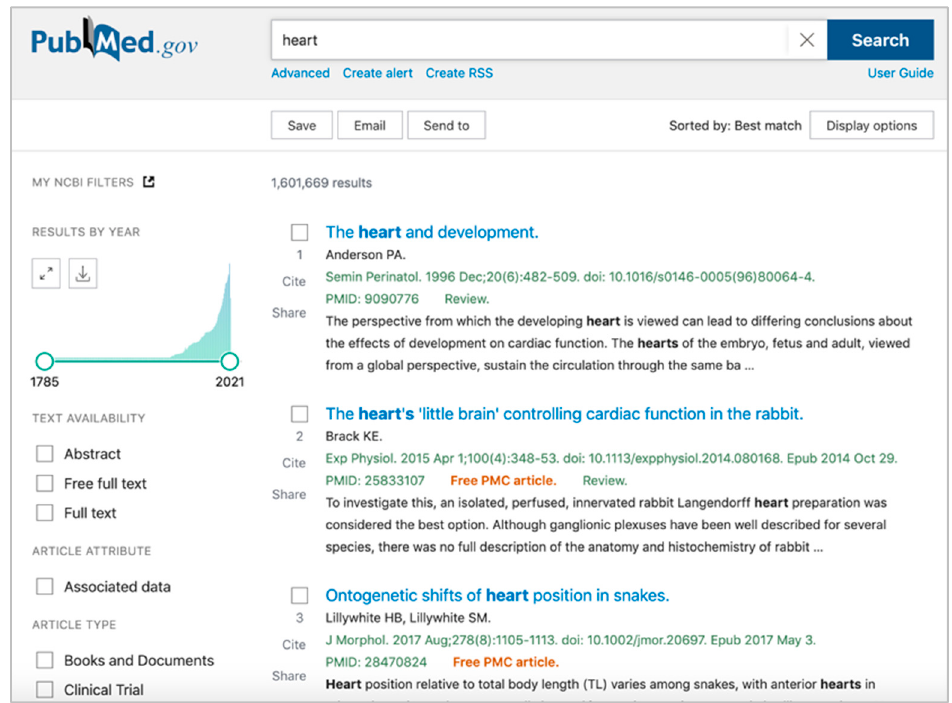
Figure 3. PubMed: Source: image generated on 5 July 2021 using the public web portal provided by the National Center for Biotechnical Information, https://pubmed.ncbi.nlm.nih.gov/?term=heart (accessed on 5 July 2021).